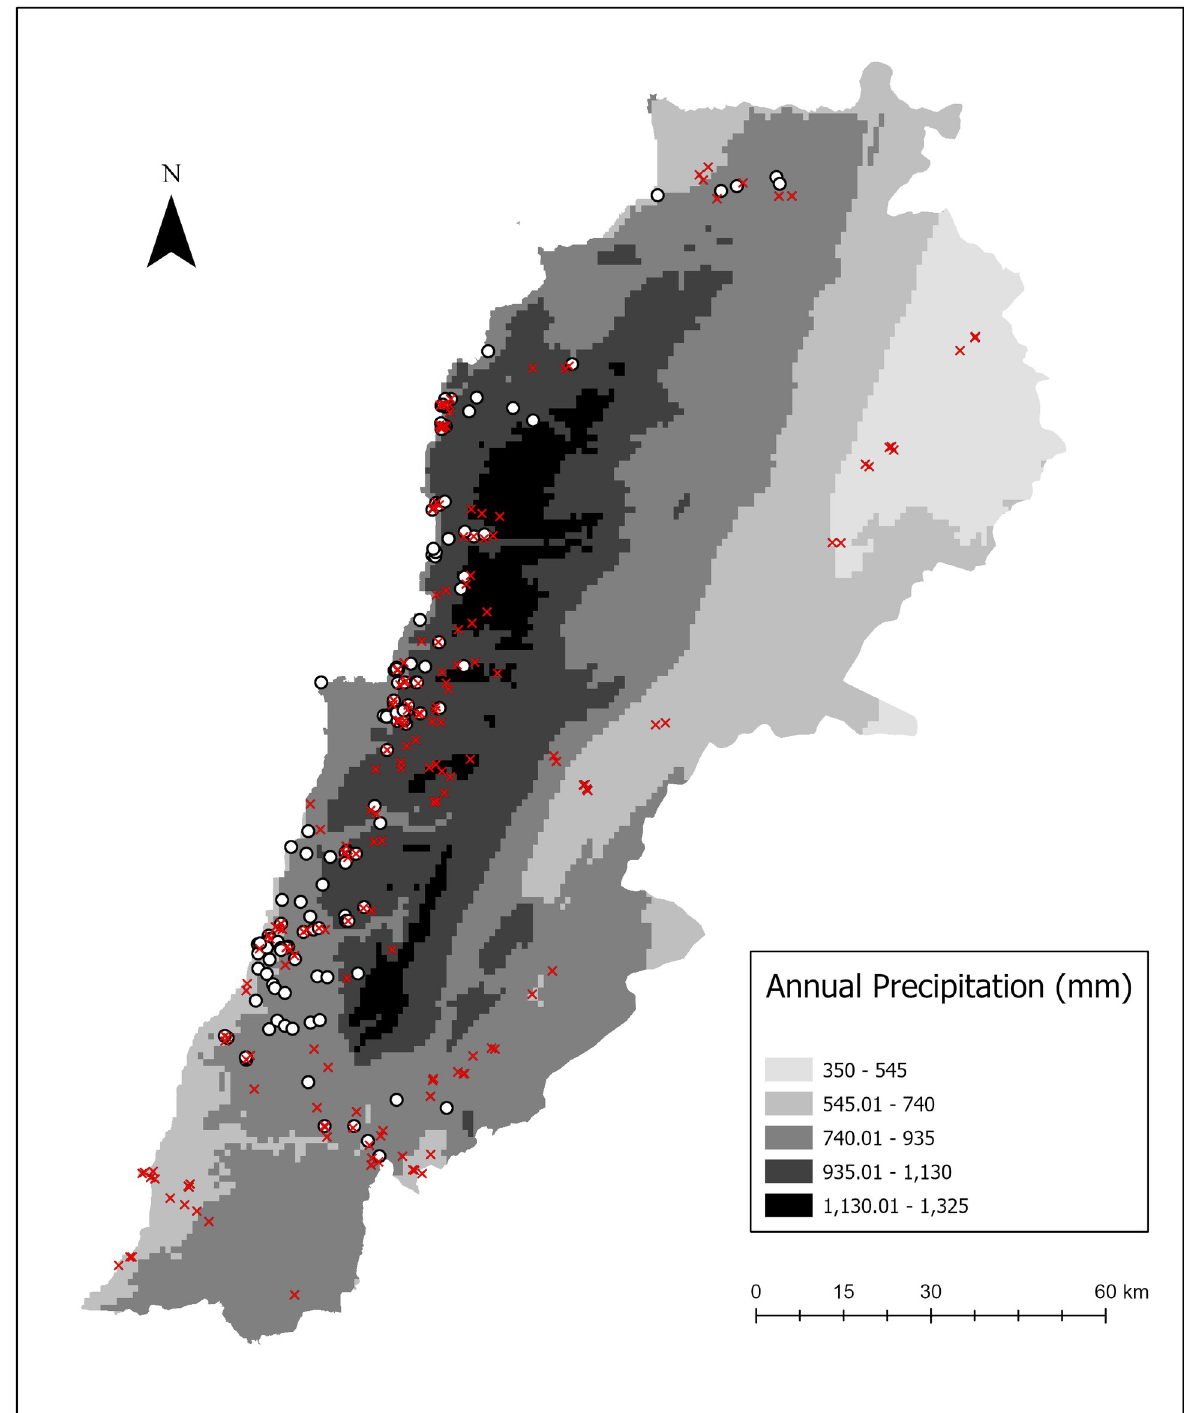
Fig 1. Average annual precipitation map showing collection points of Ae . albopictus in Lebanon during 2015 and 2018. White dots and red marks represent presence and absence locations respectively. Precipitation layer source: Fick, S.E. and R.J. Hijmans, 2017 (https://doi.org/10.1002/ joc.5086). Basemap layer source: Esri. "Human Geography" [basemap]. 1:967380. "Human Geography Base". Nov 3, 2017. https://www.arcgis.com/ home/item.html?id=2afe5b807fa74006be6363fd243ffb30. (March 3,